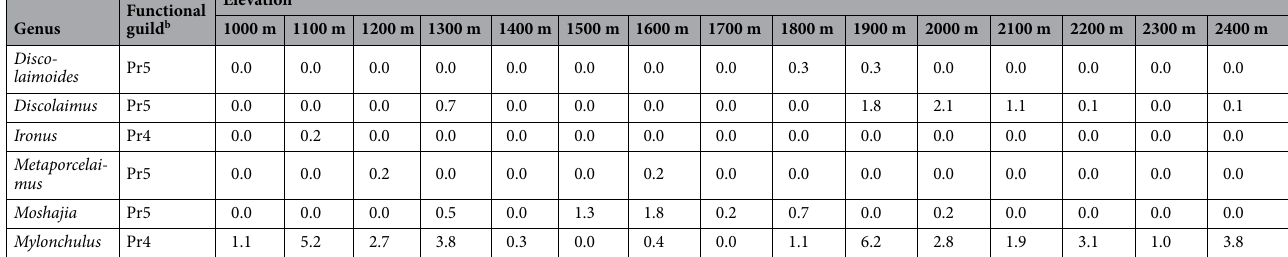
Table 2. Mean relative abundance of nematode genera (%) along elevation gradient. (n = 3). a Elevation in metres above sea level. b Functional guild is composite of trophic group and cp value: Ba Bacterivore, Fu